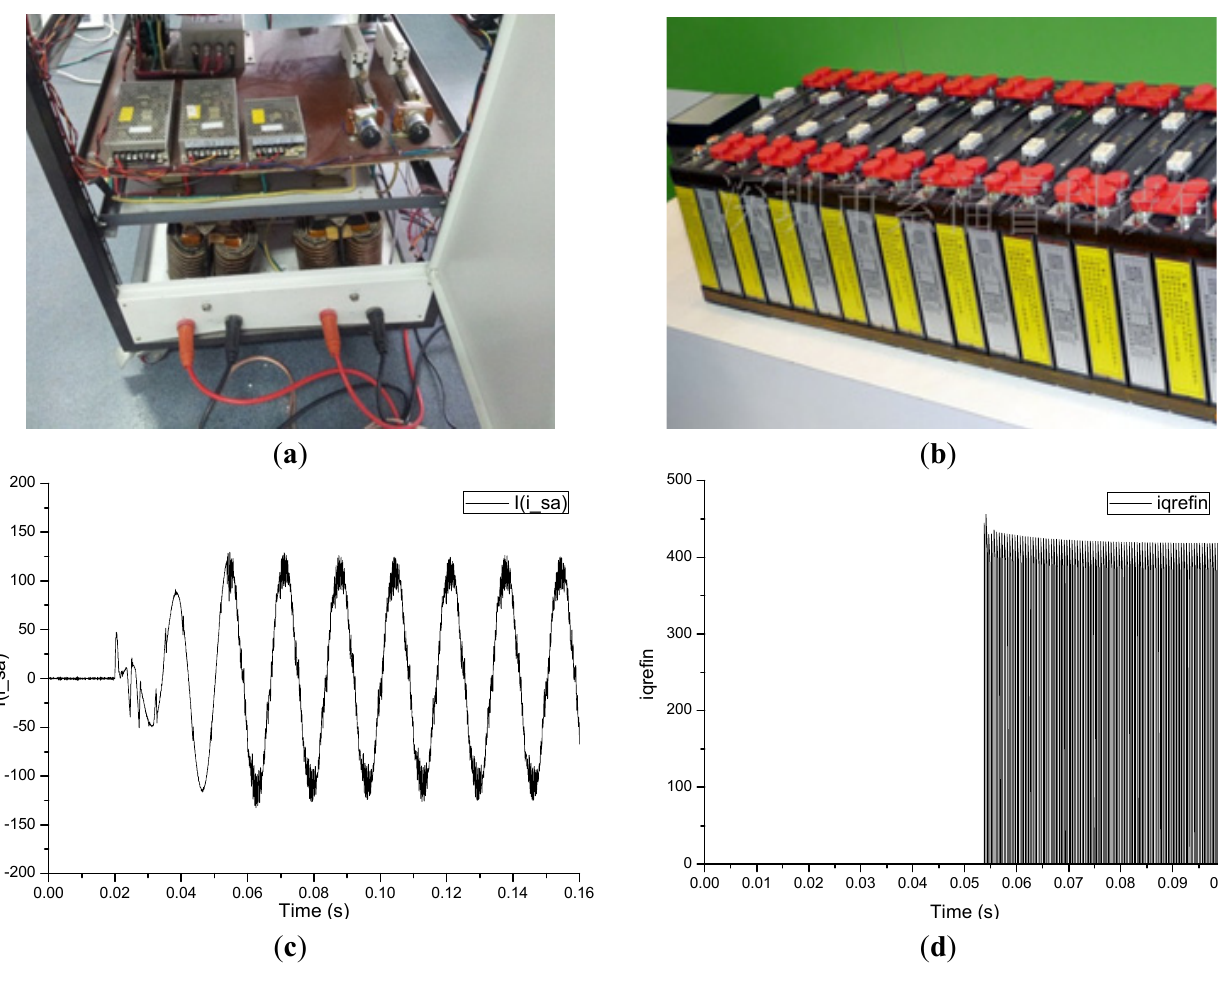
Figure 10. Hardware setup and experimental results of the proposed scheme: ( a ) power circuit configuration of the system; ( b ) Li-ion battery pack; ( c ) phase-current of the power source; ( d ) active current component injecting to the AC-grid; and ( e ) time response of the discharging current from the battery